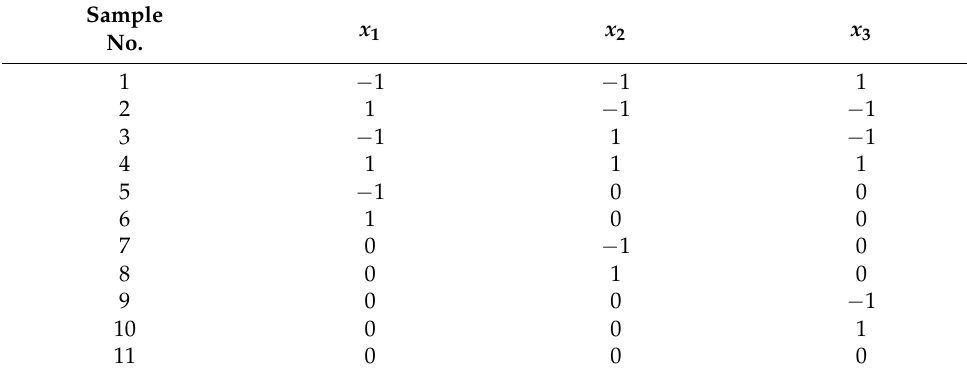
Table 1. The research plan.